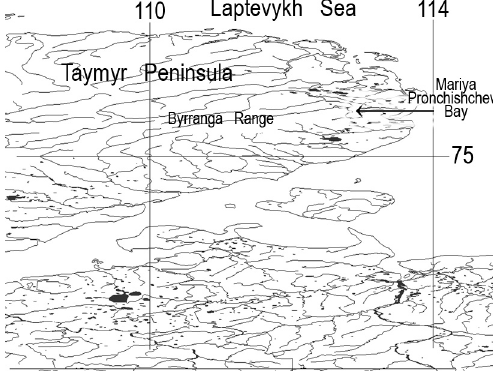
Fig. 13. Map of SE Spurs of Byrranga Range at Mariya Pronchishcheva Bay calving grounds.